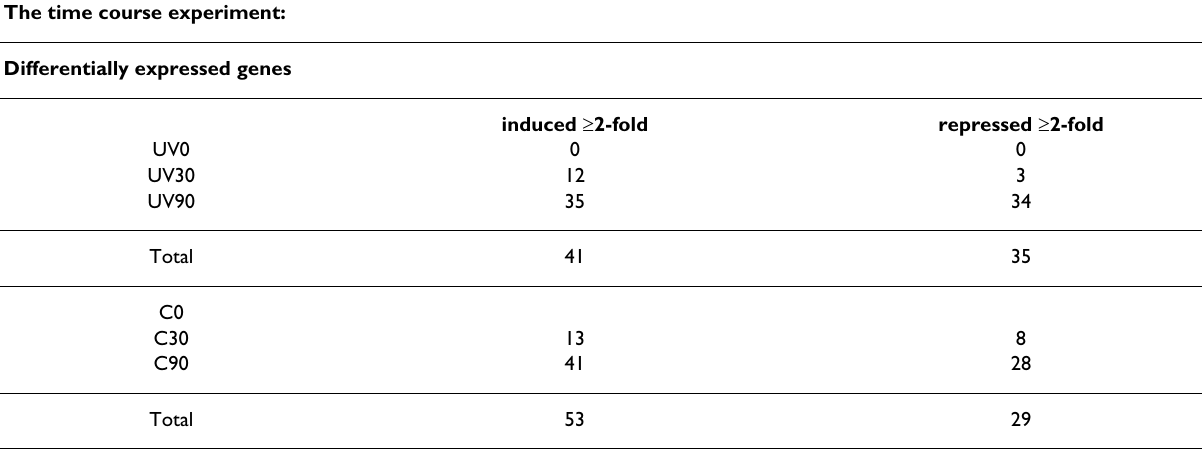
Table 2: Differentially expressed genes in the time-course experiment The time course